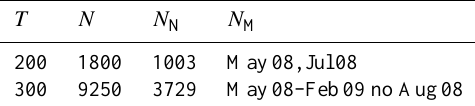
Table A1. Overview of individual half hour measurements made during the campaign. The unheated sampling line was running at all times in parallel to the heated. The following abbreviations are used T : Temperature (°C) of heated air; N : total number of half hours; N N : number of half hours of which are in Northern sector (270–90°); N M : months with data.